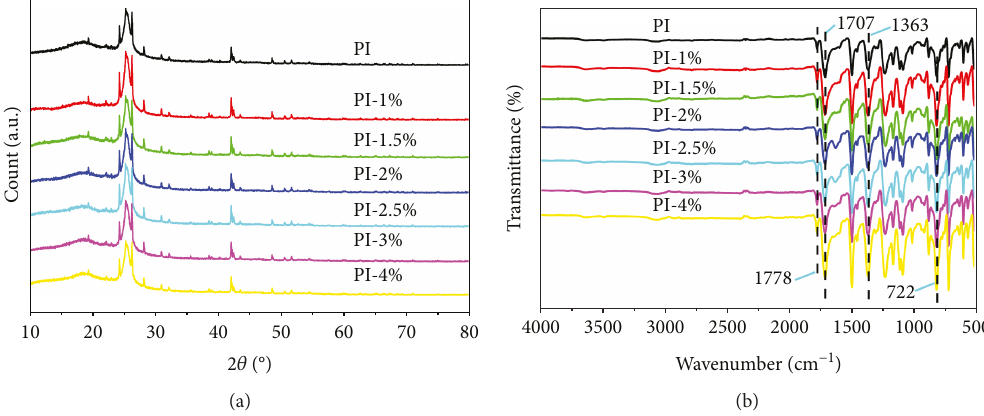
Figure 4: (a) XRD and (b) FTIR curves of pure PI and MWCNTs-ODA/PI composite fi